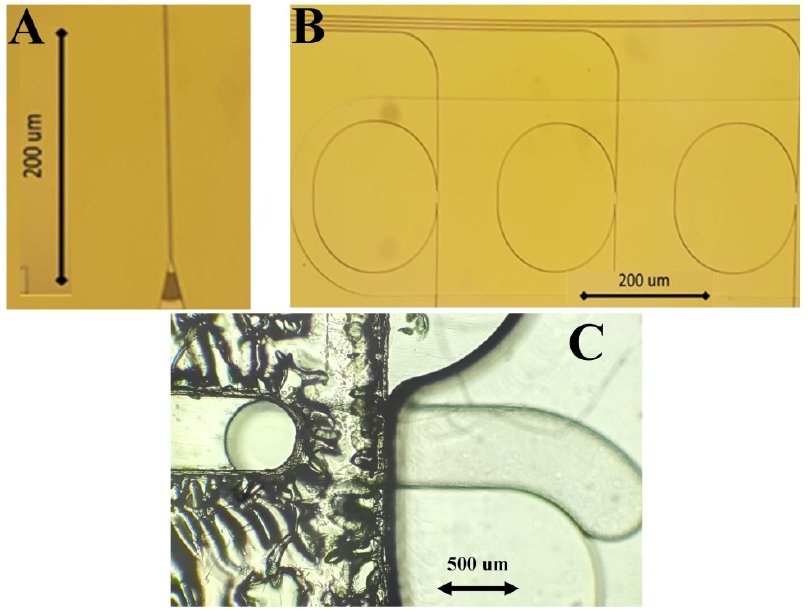
Figure 3. Microscopic images of PICs: ( A ) grating coupler, ( B ) ring resonators of PICs, and ( C ) buffer drop entering the PIC surface.